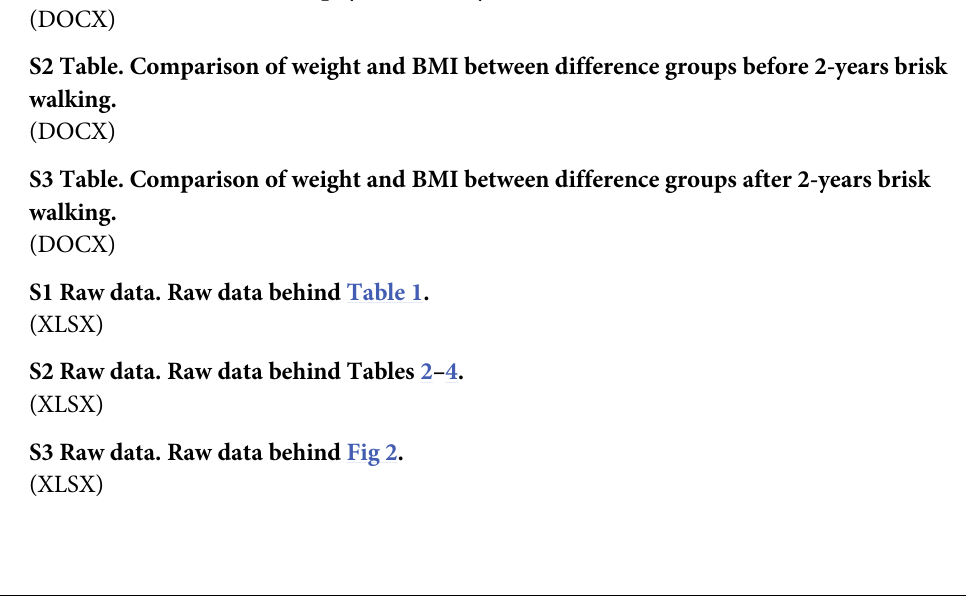
S1 Table. Questionnaire for physical activity index. S2 Table. Comparison of weight and BMI between difference groups before 2-years brisk walking. S3 Table. Comparison of weight and BMI between difference groups after 2-years brisk